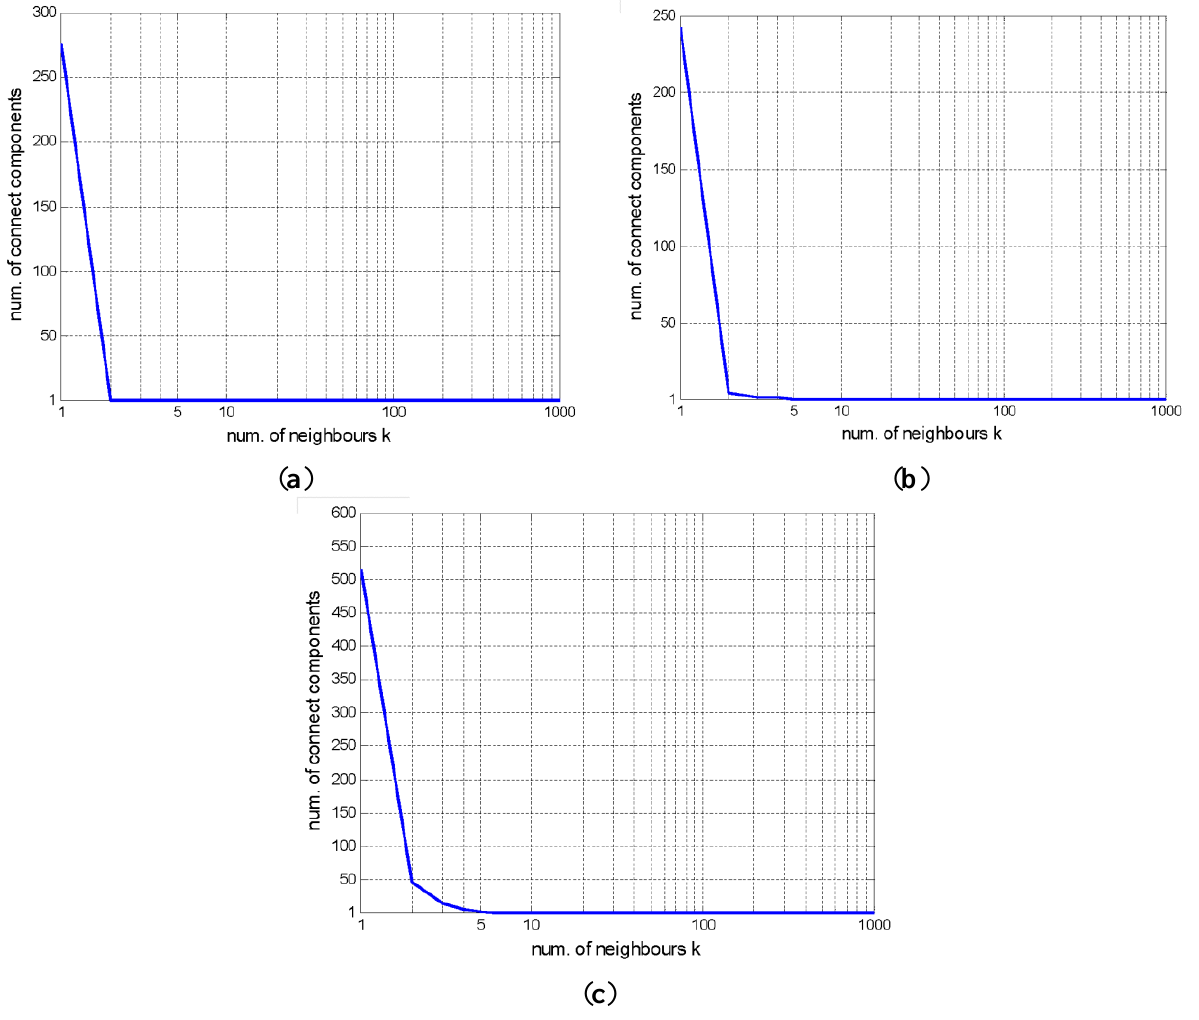
Figure 15. The number of connected components in the k -NN graph for different values of k . The curve shows the number of connected components in the k -NN graph as a function of k in the range of (1, 1000): ( a ) Beijing; ( b ) WHU-RS; and ( c )